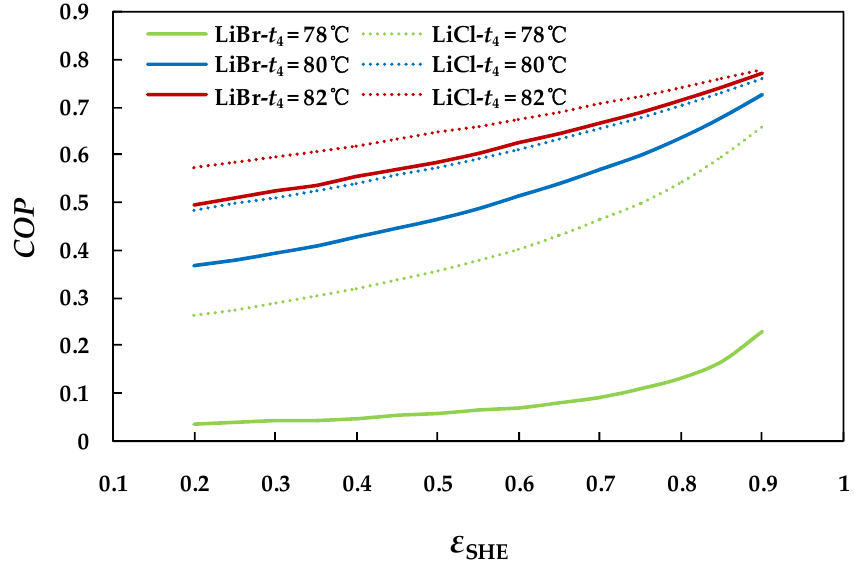
Figure 11. Heat exchanger effectiveness impact on the COP of the absorption system under various generator temperature levels (78 °C, 80 °C, and 82 °C) for the two working pairs ( t 1 = t 8 = 40 °C, t 10 = 7 °C, ε = 0.7).